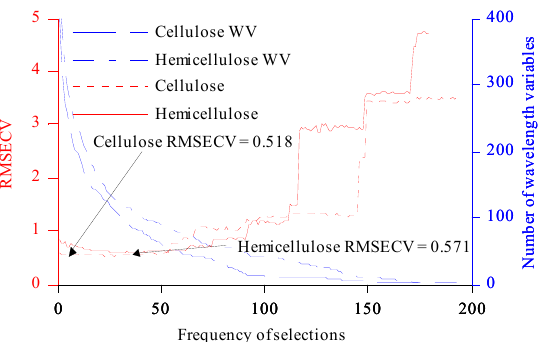
Figure 3. The relationship between RMSECV and WV and the number of selections. WV: wavelength variable.